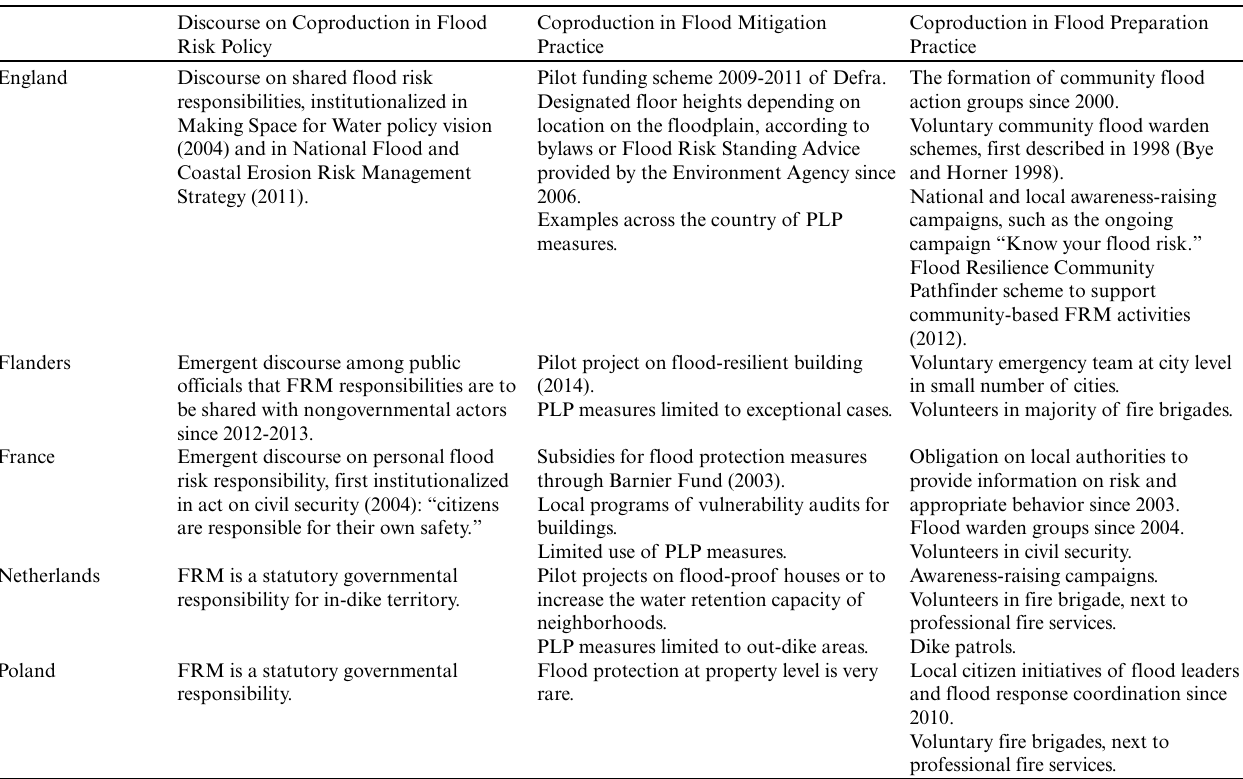
Table 2 . Discourse and practice of coproduction in the investigated